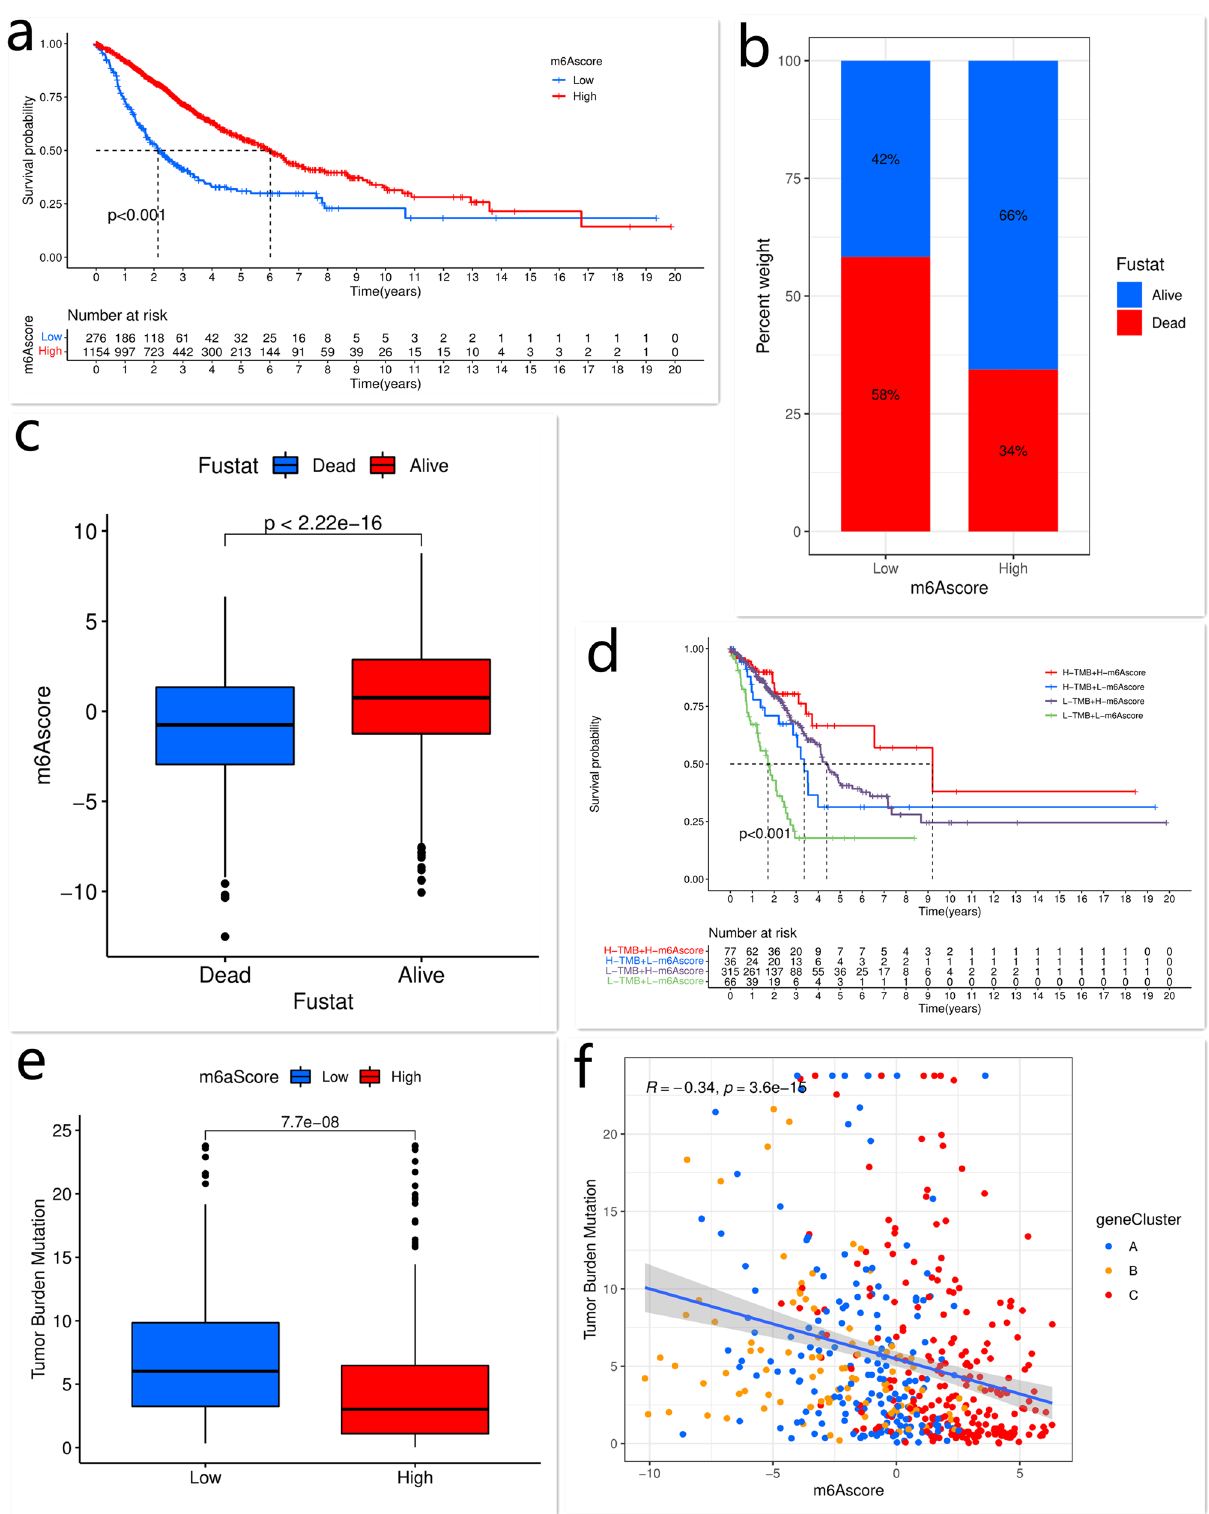
Figure 5. The correlations of the m 6 Ascore with clinical characteristics and TMB. The Kaplan–Meier curves of the OS of LUAD patients with low or high m 6 Ascore ( a ). The correlation between the m 6 Ascore and survival status (Fustat) of patients ( b , c ). The Kaplan–Meier curves of the OS of subgroup patients stratified by the m 6 Ascore and TMB ( d ). The relationship between the m 6 Ascore and TMB ( e , f ). This figure is created using the R (version 4.0.3) (https:// www.r- proje ct.